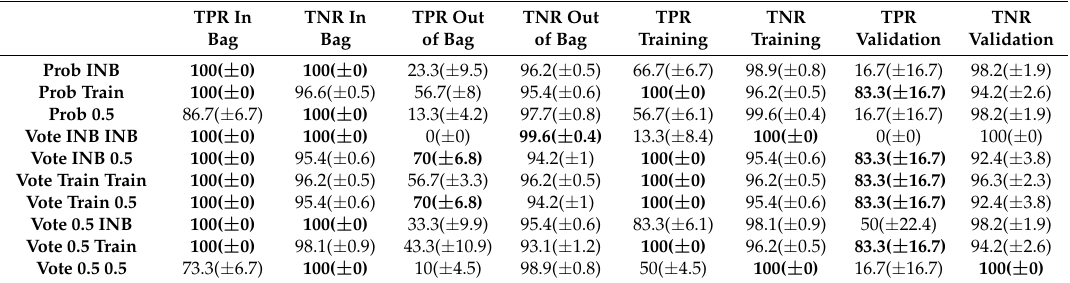
Table A3. True Positive Rate and True Negative Rate for Ventricular Fibrillation or Flutter.